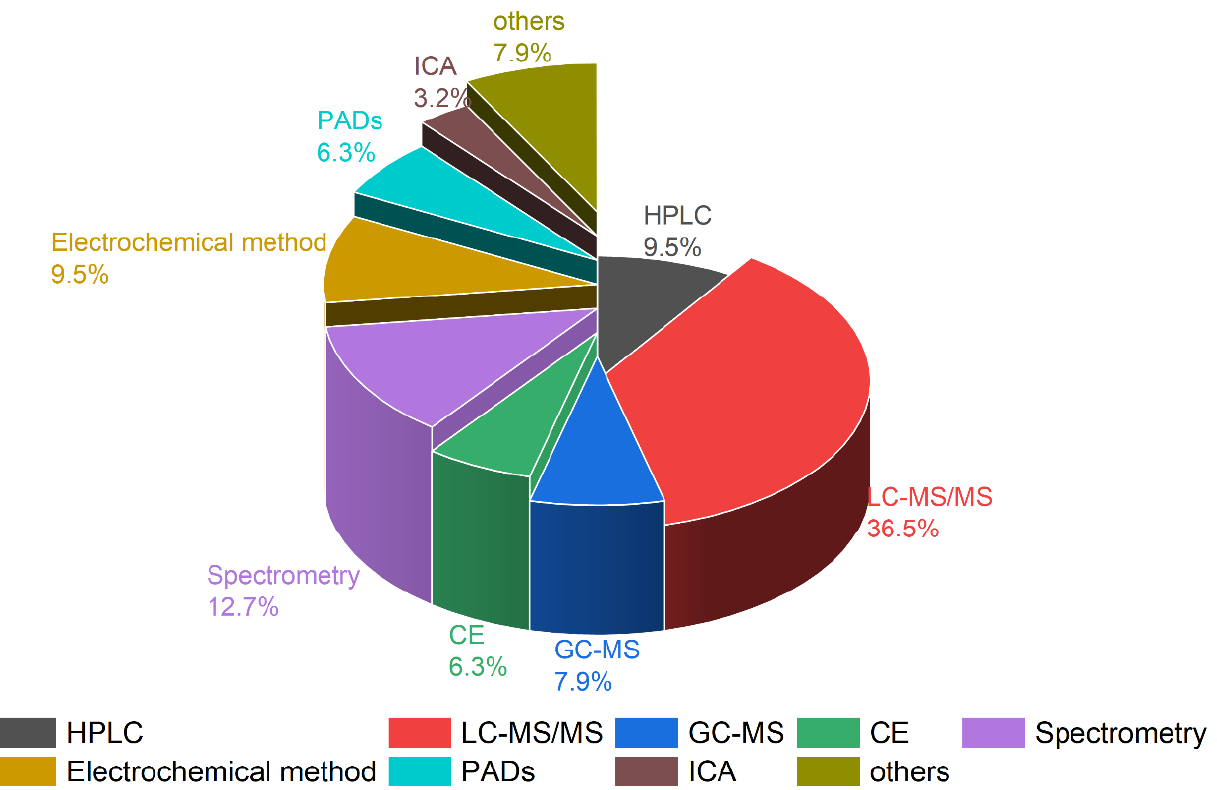
Figure 2. Comparison of the different analytical methods for paraquat and diquat in biological sam- ples.